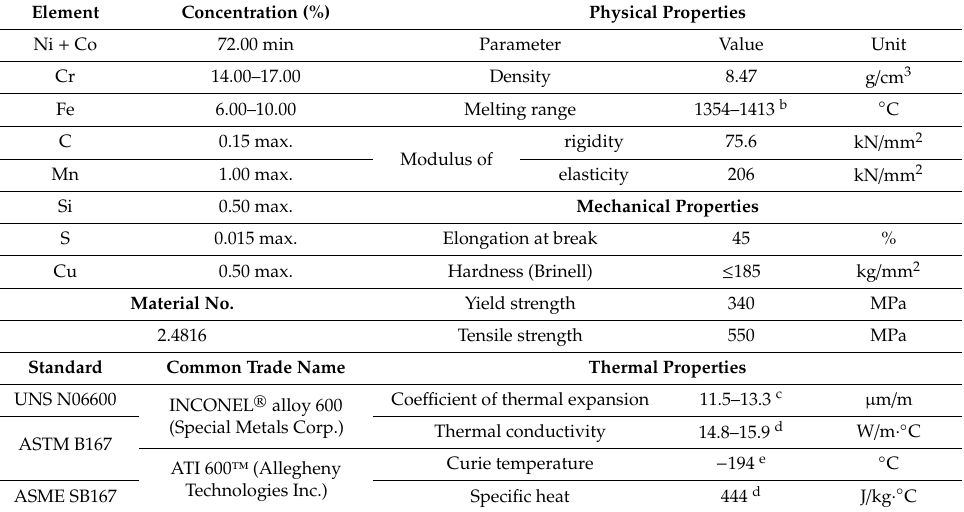
Table 3. Chemical composition of INCONEL ® alloy 600 a , as well as its selected physical, mechanical, and thermal